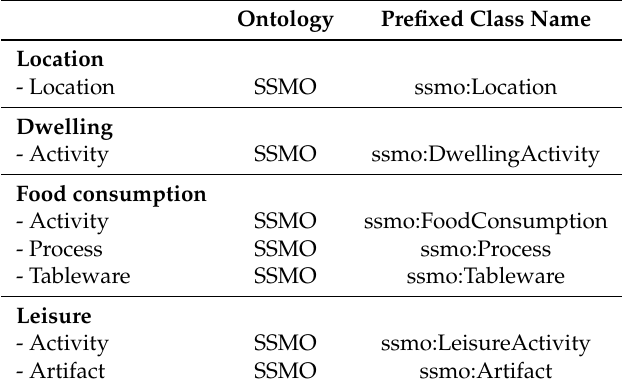
Table 4. Overview of the new entities in the SSMO ontology.